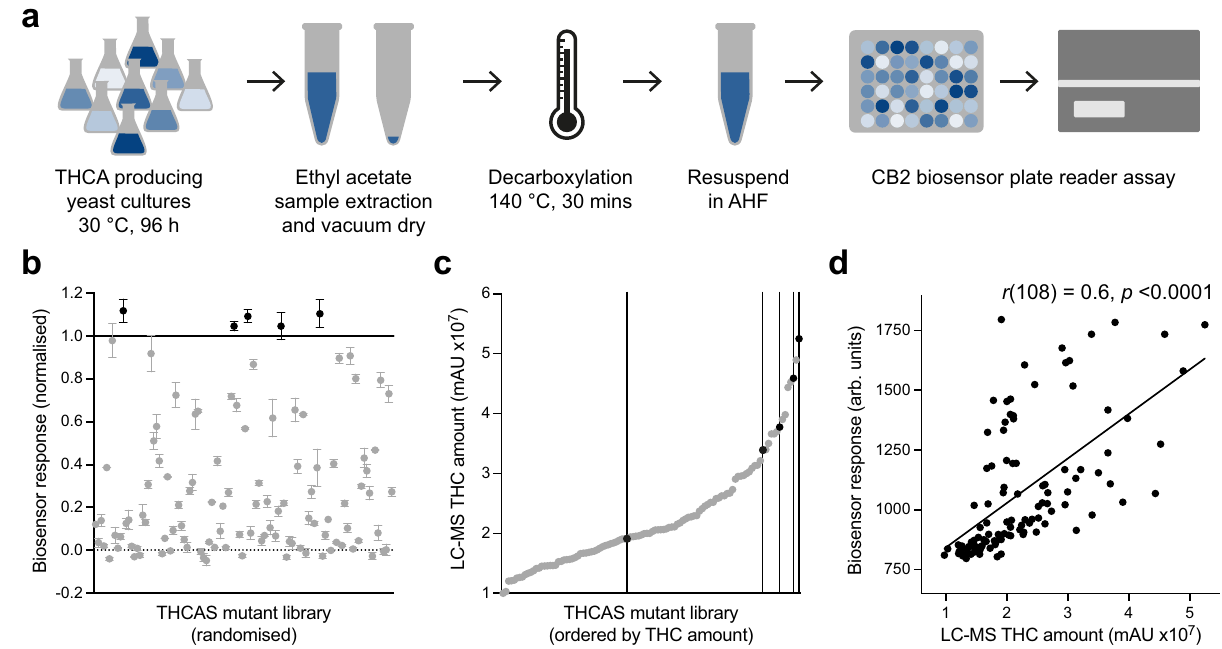
Fig. 5|Screening aTHCAS mutant yeast libraryforhigh producers.a Work fl ow for screening THC from microbial production using the yeast CB2 biosensor. AHF, acetonitrile/H 2 O/formic acid (80/20/0.05 %). b Screening a library of 108 THCAS mutant yeast strains for increased THCA production using the CB2 biosensor, highlighting fi ve stains with increased THC titres over the unmutated THCAS (black). Experimental measurements are GFP levels per cell as determined on a plate reader and shown as the mean±SD from two biosensor measurements of a single extracted sample. Measurements were normalised to no ligand (0, dotted line) and unmutated THCAS control (1, solid line). Samples with StDev > 5 % of the